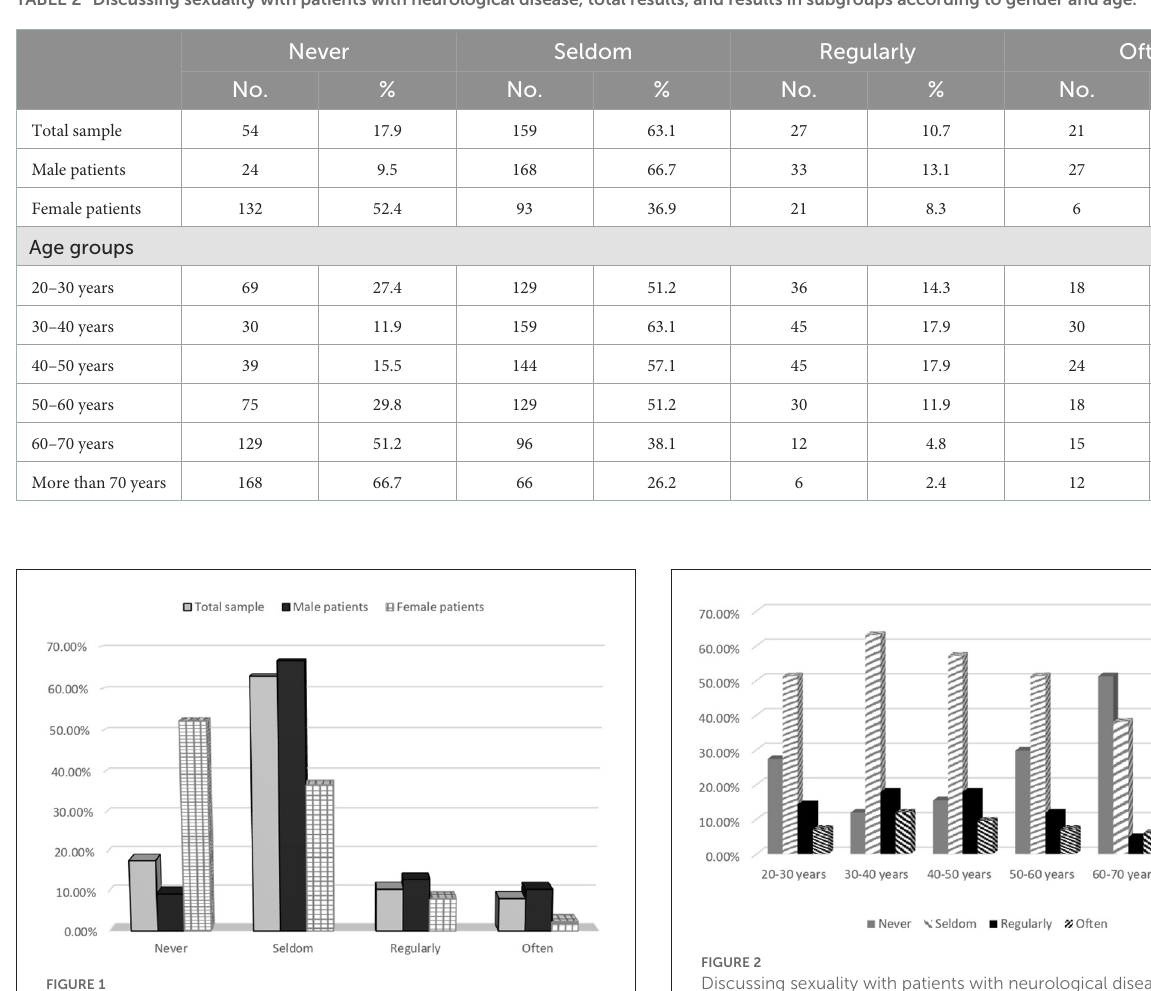
(82.1%), insufficient consultation time (60.7%), and barriers based on language/culture/religion (53.6%). The majority of participants (63.1%) did not consider the age difference between the neurologists and patients as a possible